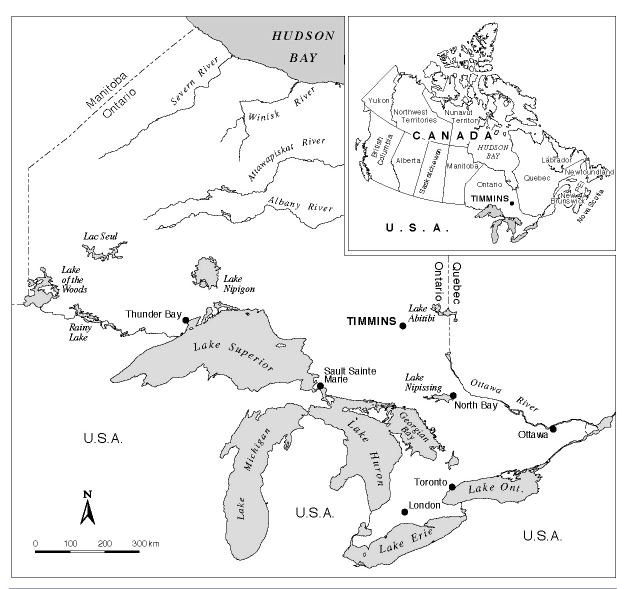
Fig. 1 . Map of Timmins, Ontario,